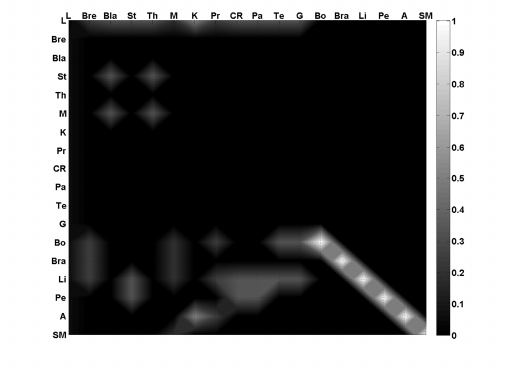
Fig. 2: Visualization of the transition matrix, in gray scale, for secondary sites.